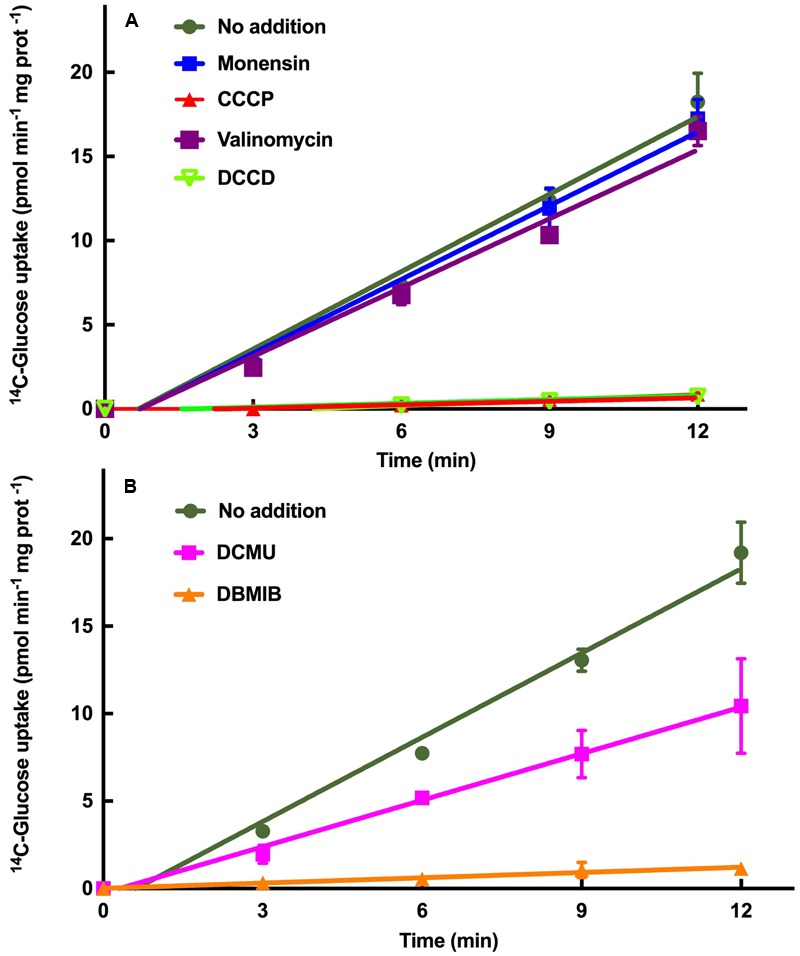
Characterization of the GlcH transporter of Prochlorococcus sp. SS120 with specific inhibitors. (A) Effect of monensin, CCCP, valinomycin and DCCD on glucose uptake. (B) Effect of DCMU and DBMIB on glucose uptake. In both graphs the data are the average of three independent biological replicates. Bars show standard deviation for each sample.